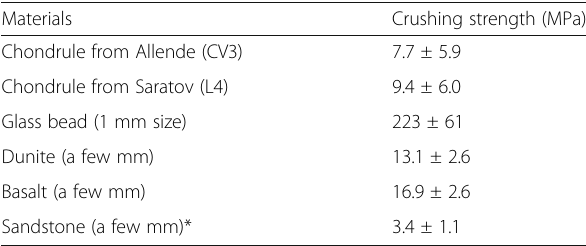
Table 7 Crushing strength of various materials from Shigaki